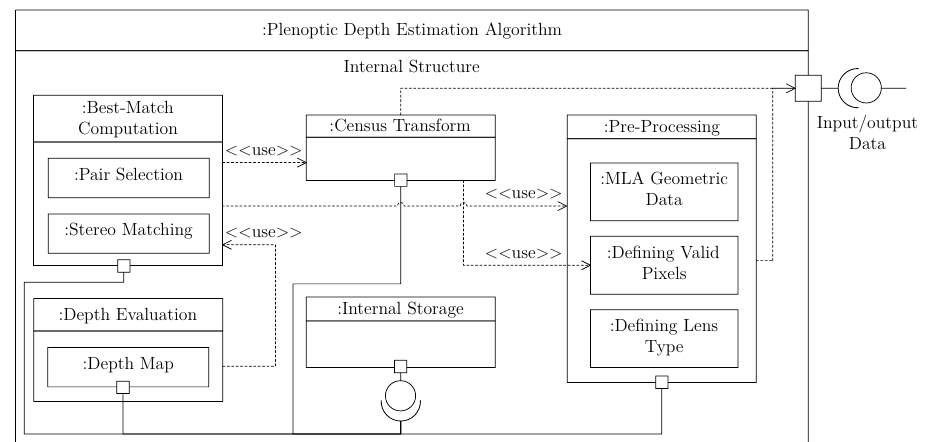
Figure 8. UML structure diagram showing the dependencies between different components of the algorithm.